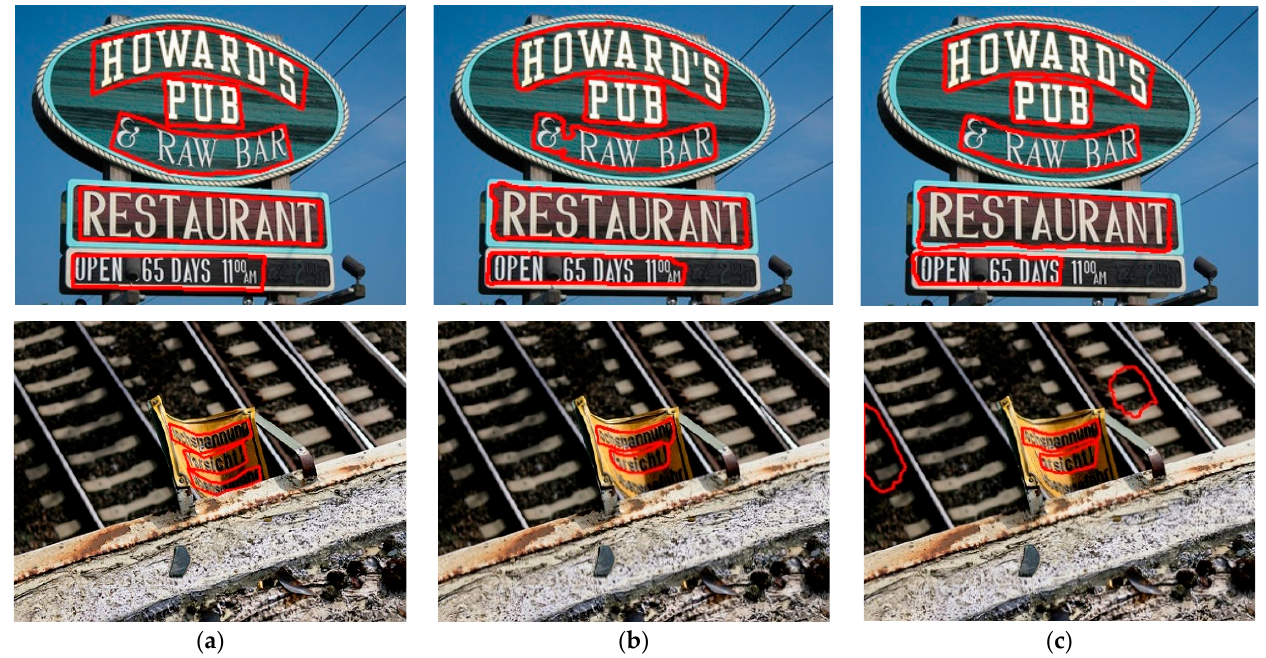
Figure 6. Visualization results on CTW1500, ( a ) for ground truth, ( b ) for the results of this paper’s algorithm, ( c ) for PSENet model detection.